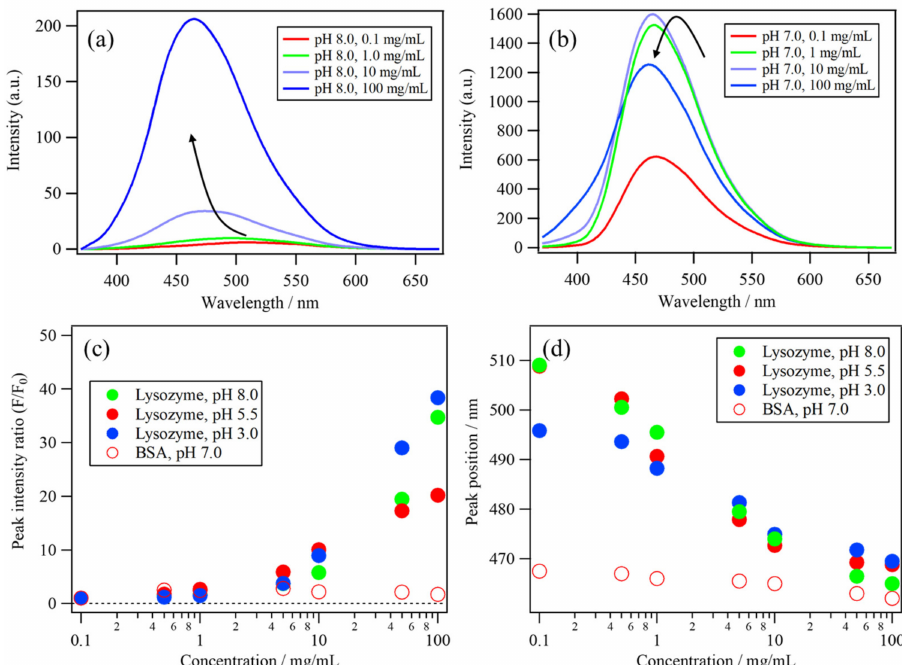
Figure 4. The protein concentration dependences of the ANS fluorescence of ( a ) lysozyme solution (pH 8.0) and ( b ) BSA solution (pH 7.0). The protein concentration dependences of ( c ) the peak intensity ratio (F/F 0 ) and ( d ) the peak position of the ANS fluorescence band of lysozyme at pH 8.0, 5.5, and 3.0 and of BSA at pH